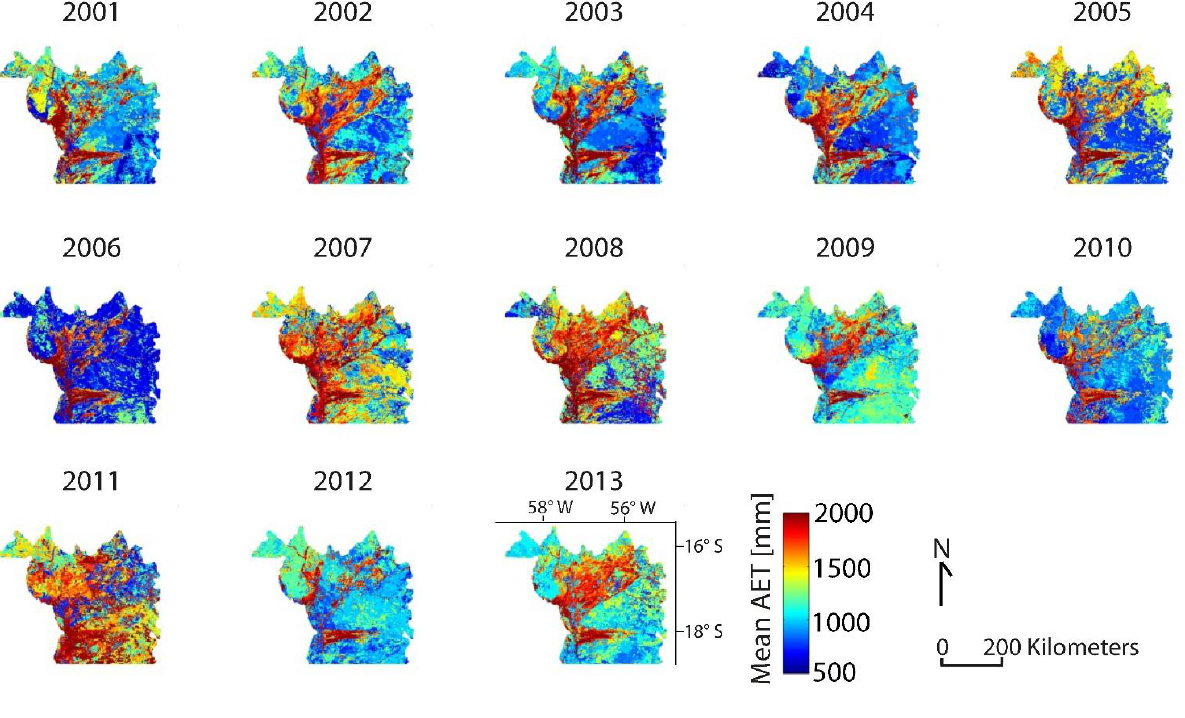
Figure 7. Simulated yearly means of actual evaporation (AET) [mm] for the years 2001 to 2013, where the map area corresponds to the Pantanal area located inside the MODIS tile (Figure